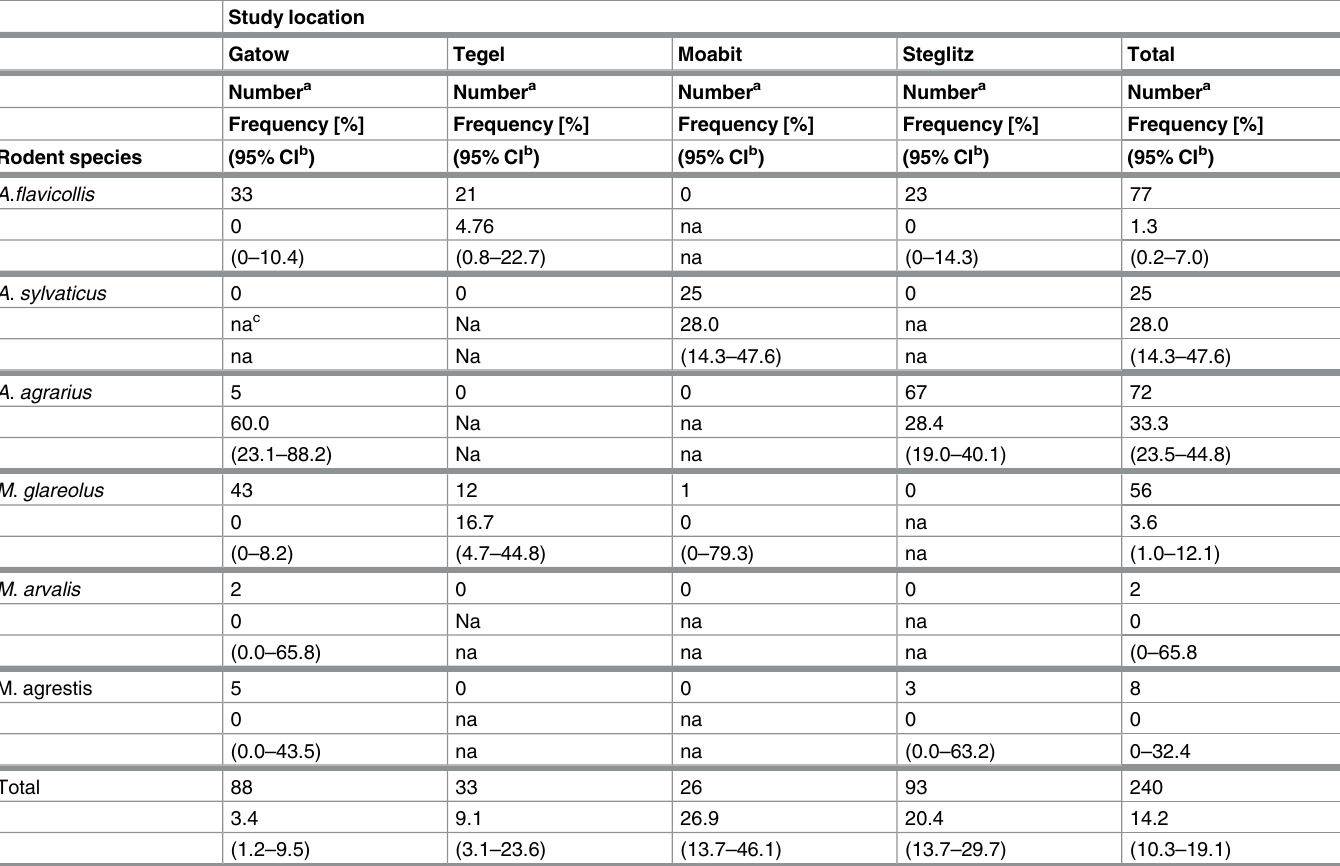
Table 3. Prevalence rates of antibodies against Toxocara canis excretory-secretoryantigen. Study